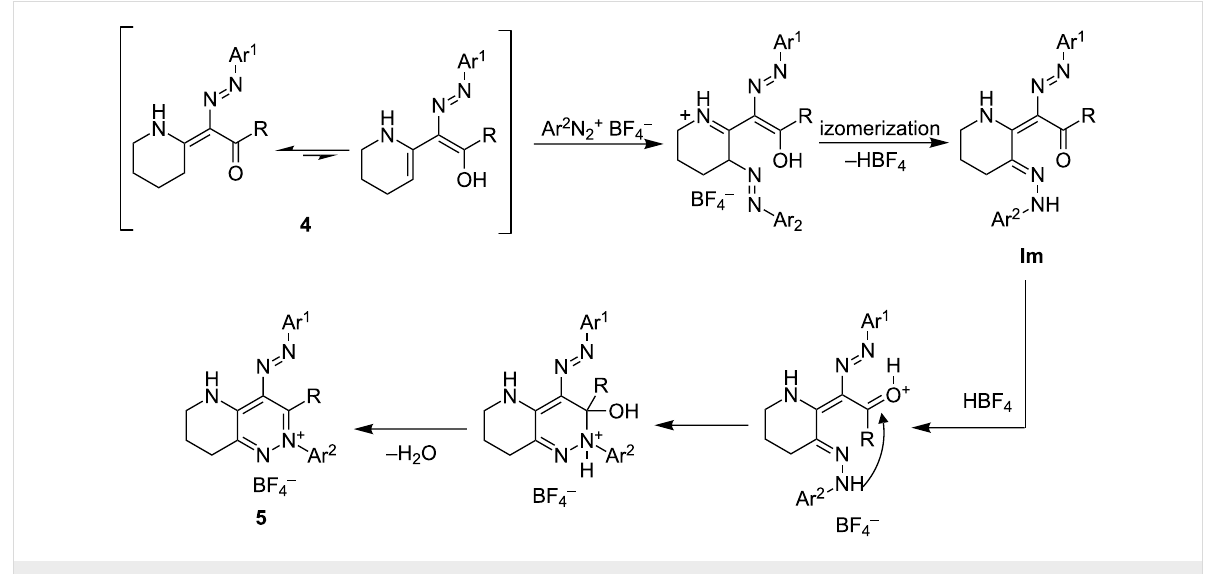
Scheme 5: Possible mechanism of the formation of the pyridazinium salts 5 .